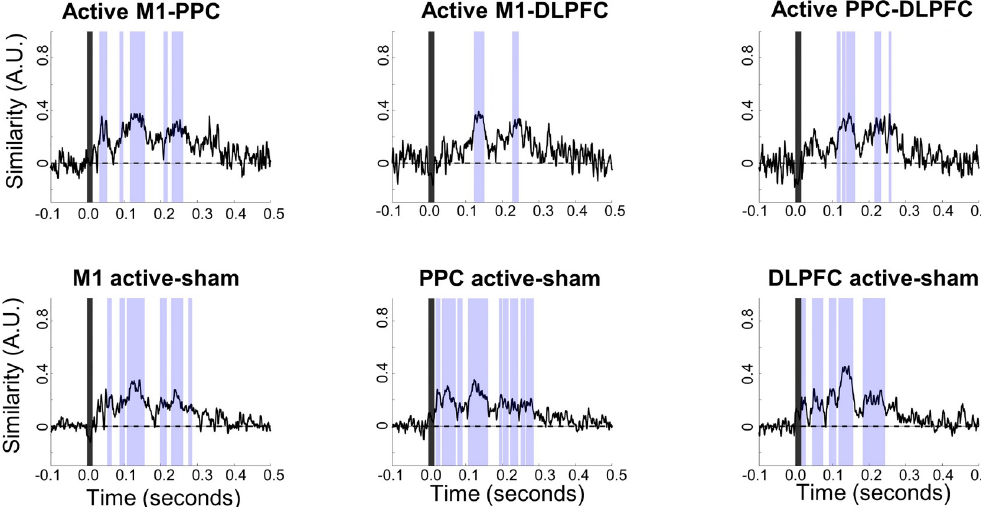
Fig 6. Between-site and between-condition similarity curves. Lightly shaded regions shows epochs of significant difference from baseline, indicating that similarity between the compared conditions is above chance. The darkly shaded regions from -1 ms to 15 ms indicate TMS pulse